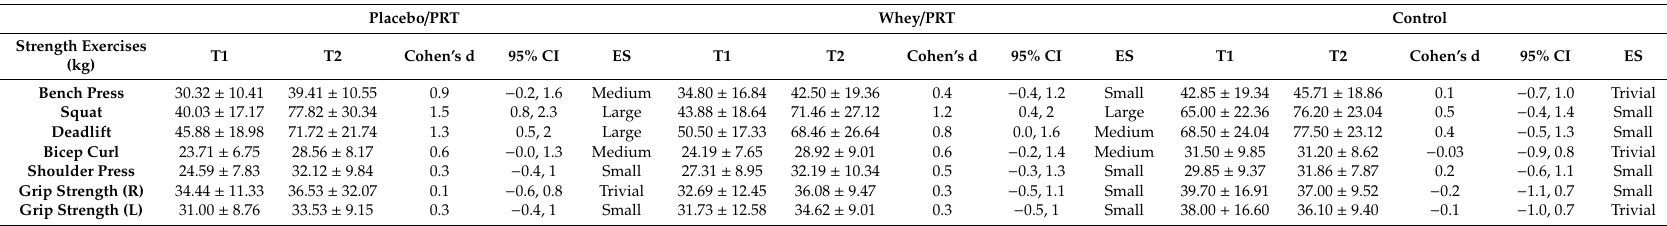
Table 3. E ff ect sizes (ES) of one-repetition maximum (1RM) strength indices from T1 to T2 in the placebo / PRT, whey / PRT, and control groups in HIV-infected individuals receiving ART (mean ± SD). Whey / PRT Control